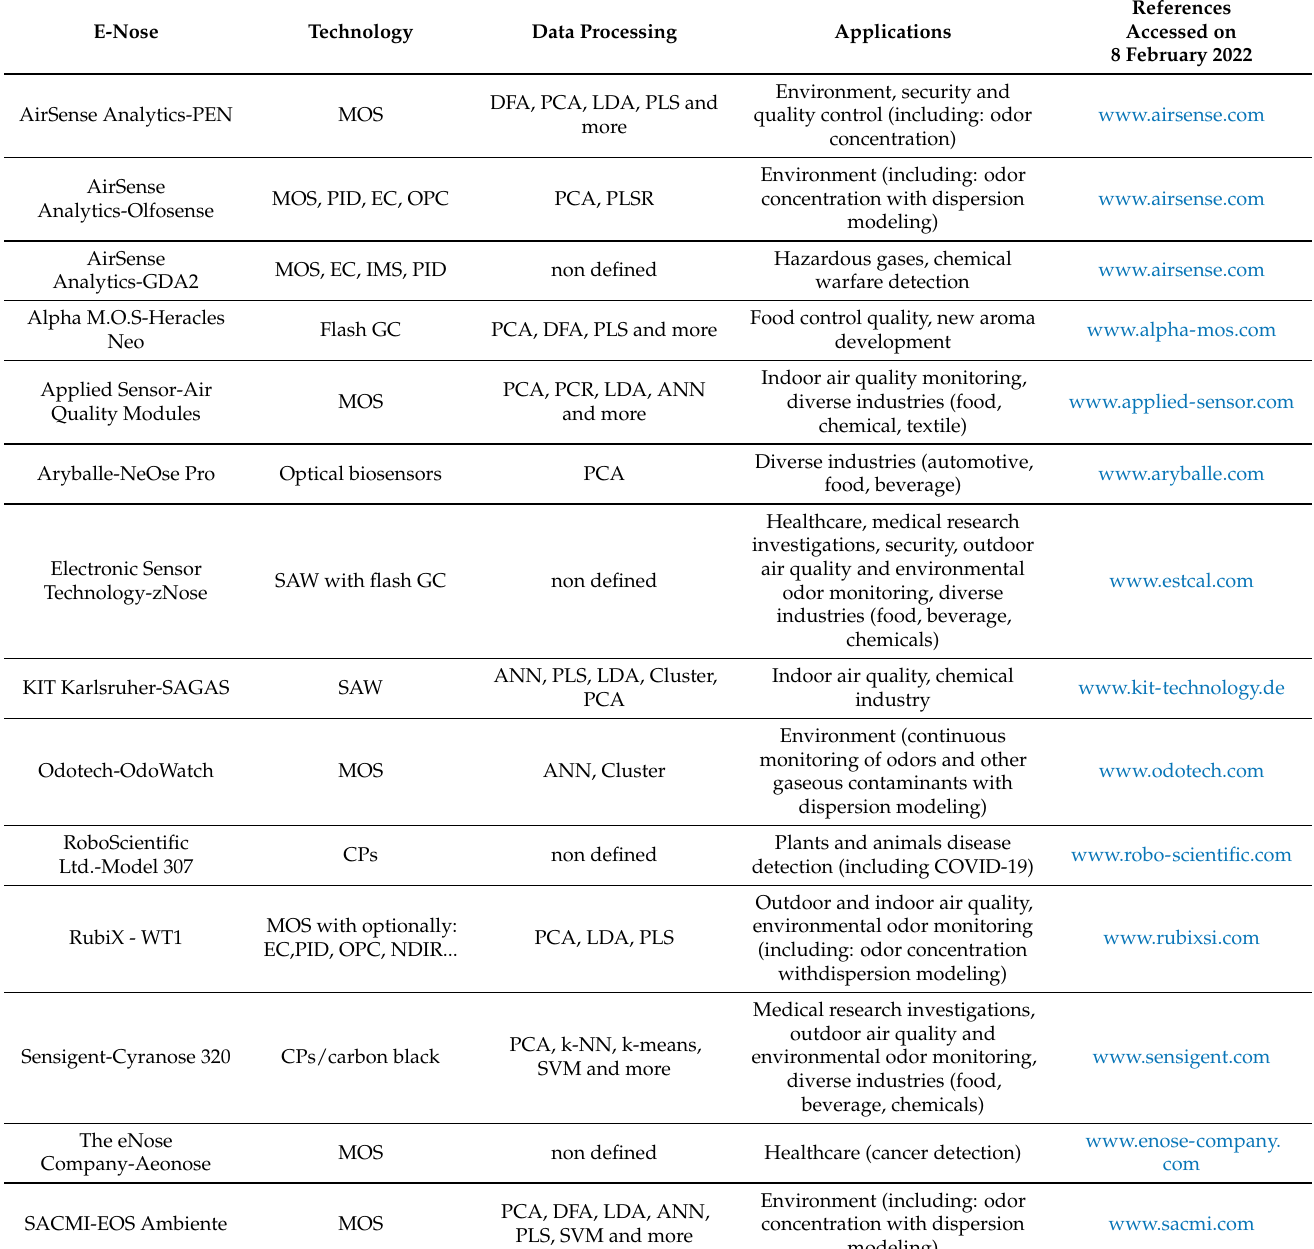
Table 6. Examples of commercial